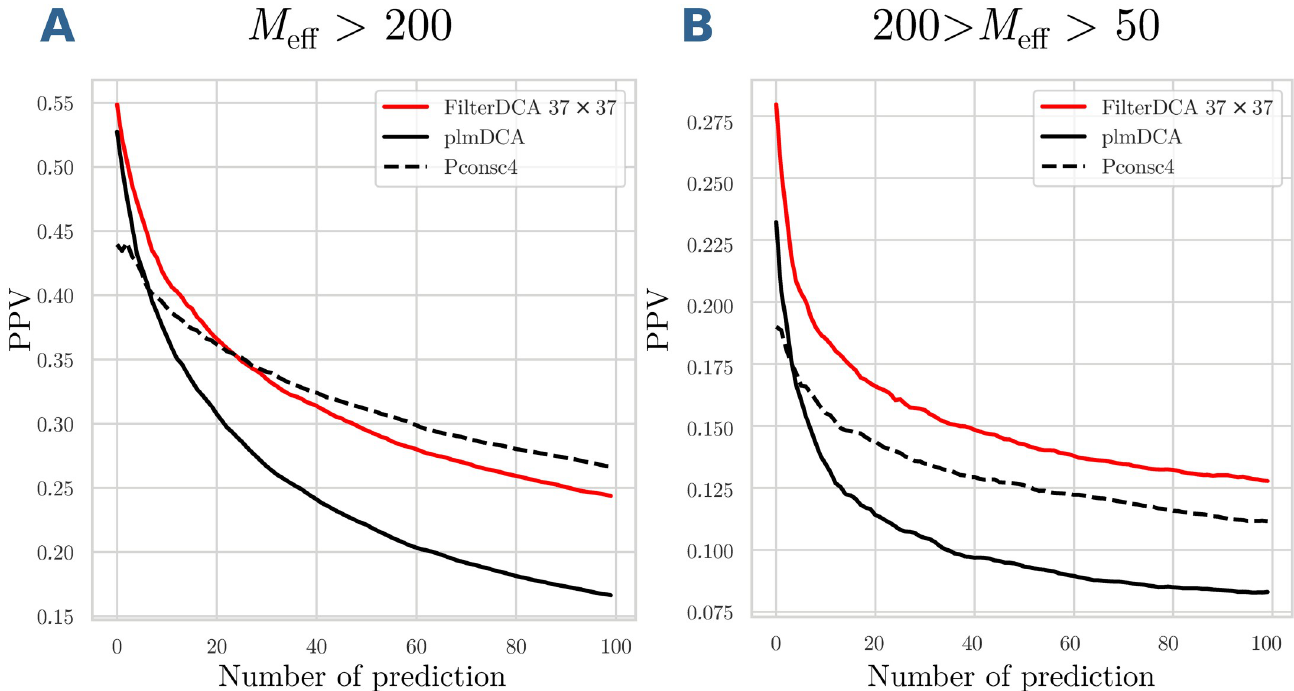
Fig 10. Positive predictive values for inter-domain contact prediction. PPVs for plmDCA, FilterDCA and PconsC4 are shown as a function of the number of predictions, averaged over the different domain-domain interactions in the test set. Predictions within 5 residues from the concatenation of the two domains are removed from the prediction, since they provide incoherent inputs to CNN and tend to produce many FP; this artifact strongly reduces the accuracy of CNN-based contact